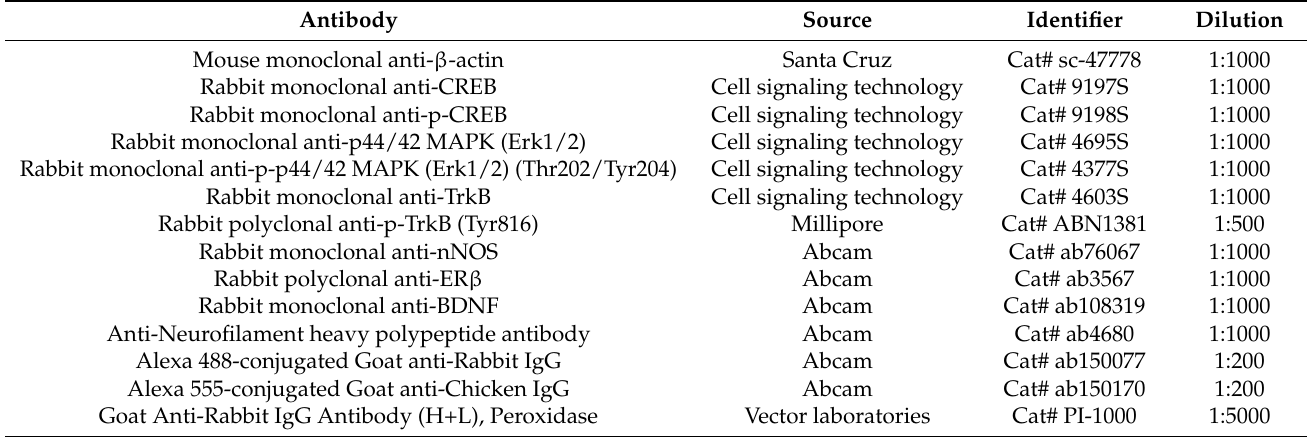
Table 1. Antibodies used in this